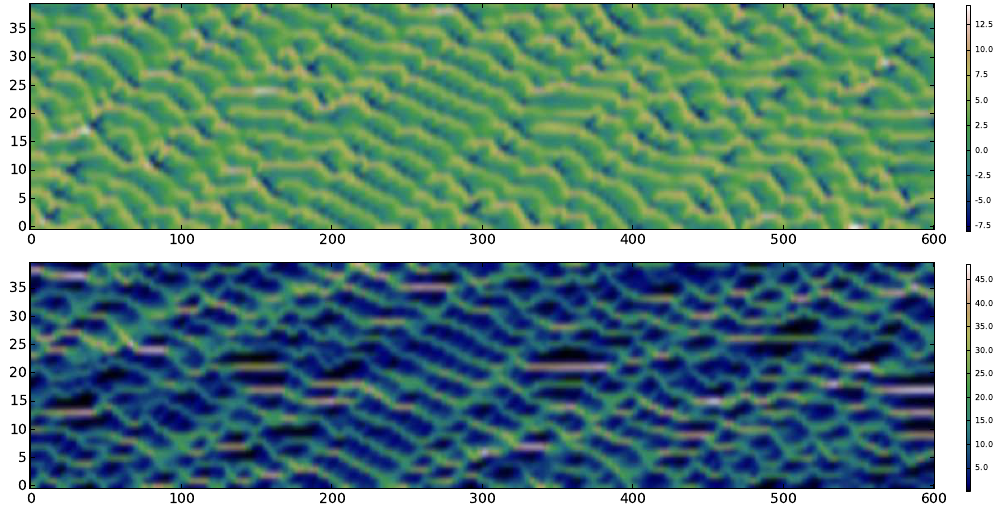
Fig. 8. Time evolution of the wind (top) and concentration (bottom) fields of the coupled Lorenz ’95 - tracer model.